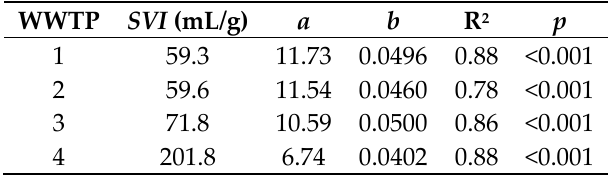
Figure 2. Relationship between parameter a and the sludge volume index ( SVI ). Table 1. The sludge volume index ( SVI ), parameters a and b , coefficient of determination (R 2 ), and p -values for the regression analyses of the wastewater treatment plants (WWTPs)